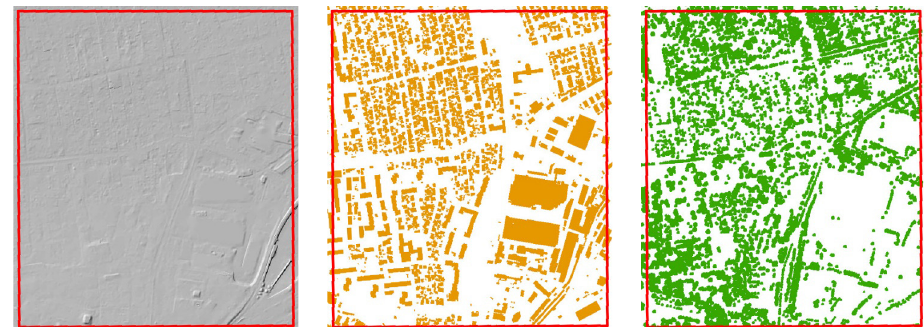
Figure 2. Study area in Lviv city, Ukraine